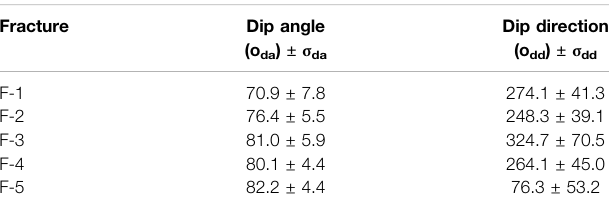
TABLE2| Meanapertureandstandarddeviationofthedipangleanddipdirection measurements of the FTP orientations belonging to the individual fractures analyzed.